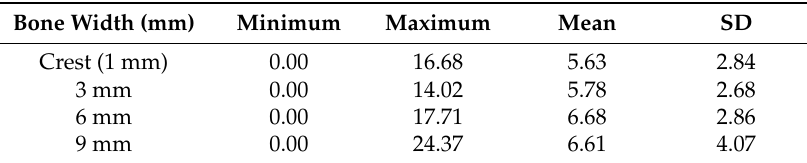
Table 1. Mean bone width at the different measured MDI sections.